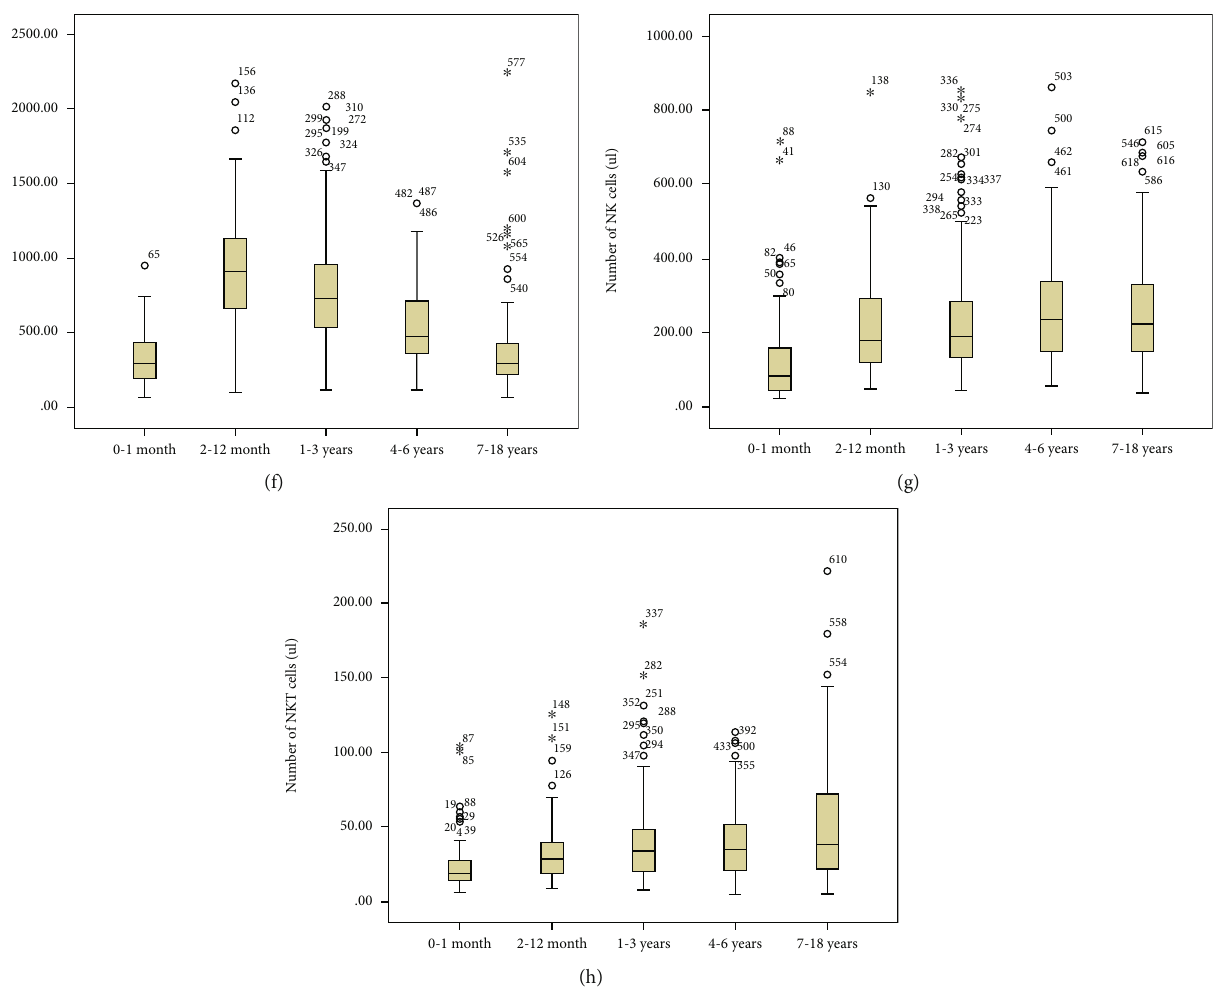
Figure 2: The number of (a) total lymphocyte, (b) T cell, (c) CD4 T cell, (d) CD8 T cell, (e) DNT cell, (f) B cell, (g) NK cell, and (h) NKT cell in Chinese children with di ff erent age groups. The uppermost and lowermost lines represent the minimum to maximum. The line through the middle of the box represents the median. The bottom and top of the box represent third quartile and fi rst quartile. Asterisks and circles represent extreme values in the sample data,